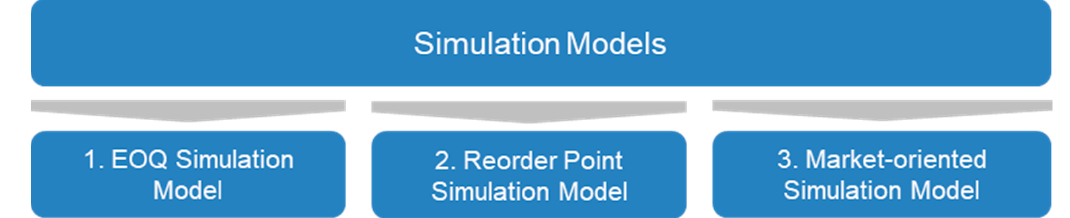
Figure 4. Simulation models (own elaboration). Economic order quantity (EOQ).